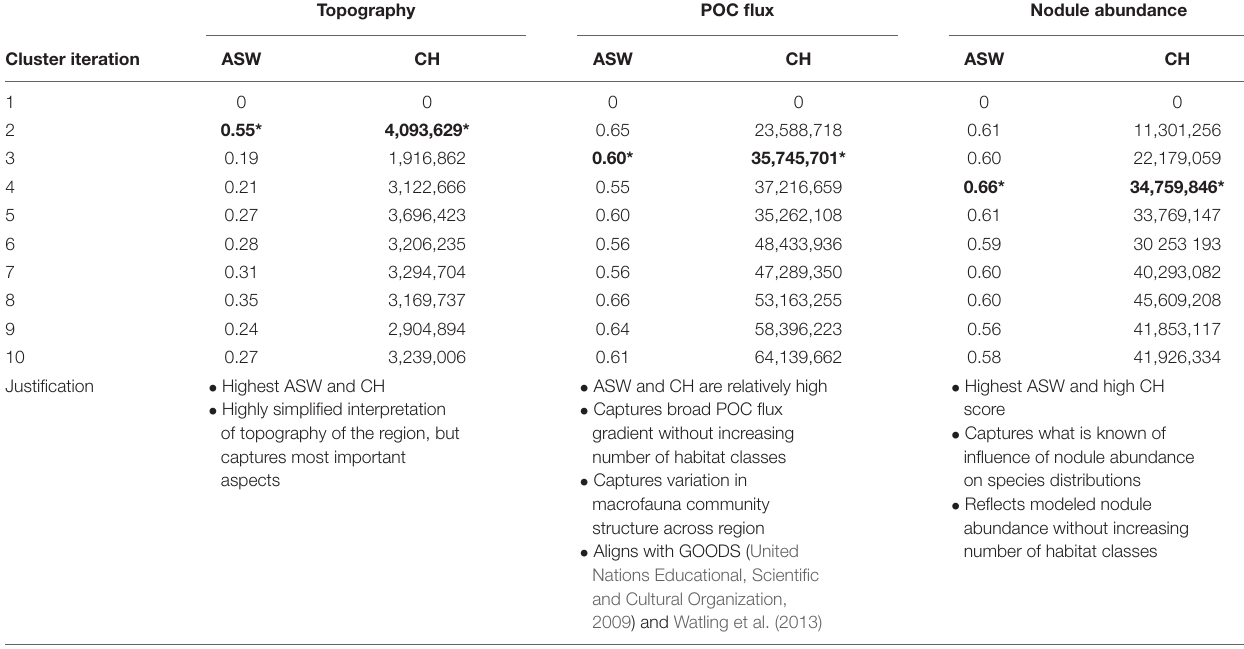
TABLE 1 | Average silhouette width (ASW) and Calinski-Harabasz index (CH) for CLARA clustering iterations with 1–10 clusters for each class of environmental variables. Topography